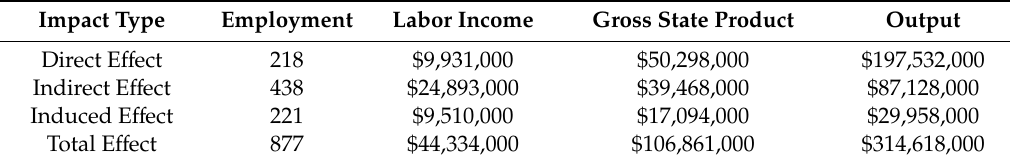
Table 3. Economic contribution of brewing activities.